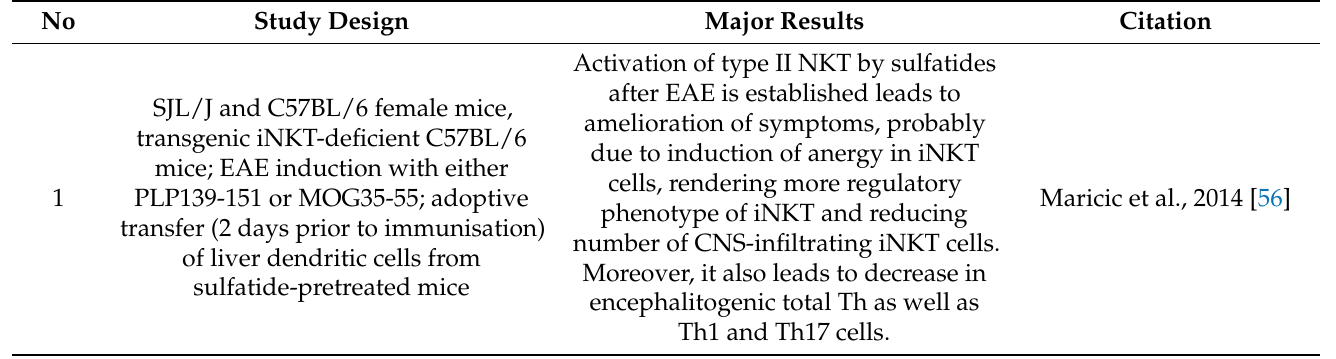
Table 2. Involvement of type II NKT in EAE—major